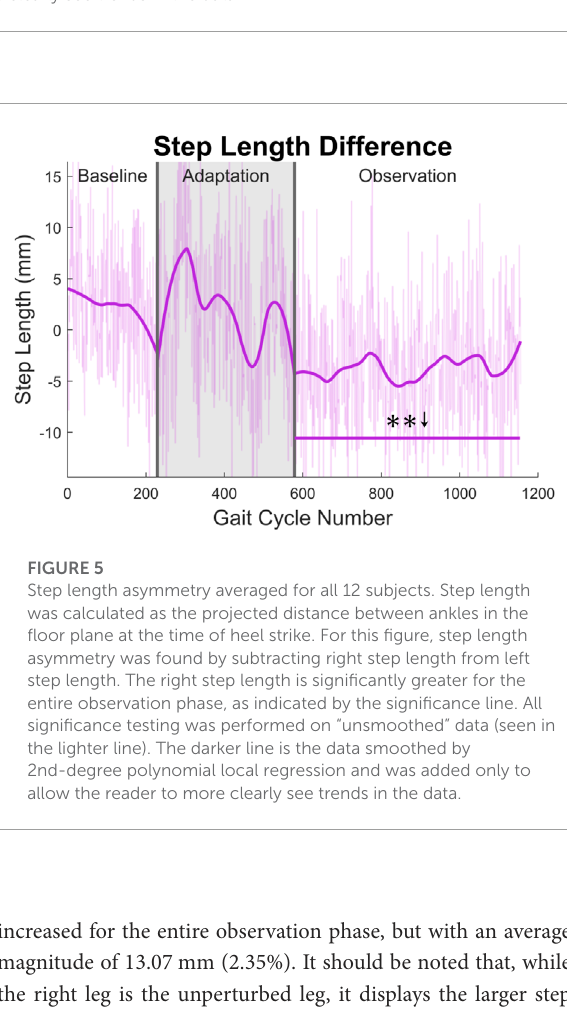
FIGURE 4 Left and right step length averaged for all 12 subjects. Step length was calculated as the projected distance between ankles in the floor plane at the time of heel strike. Both left and right step lengths are statistically significant for the entire observation phase, as indicated by the significance line. All significance testing was performed on “unsmoothed” data (seen in the lighter line). The darker line is the data smoothed by 2nd-degree polynomial local regression and was added only to allow the reader to more clearly see trends in the data.